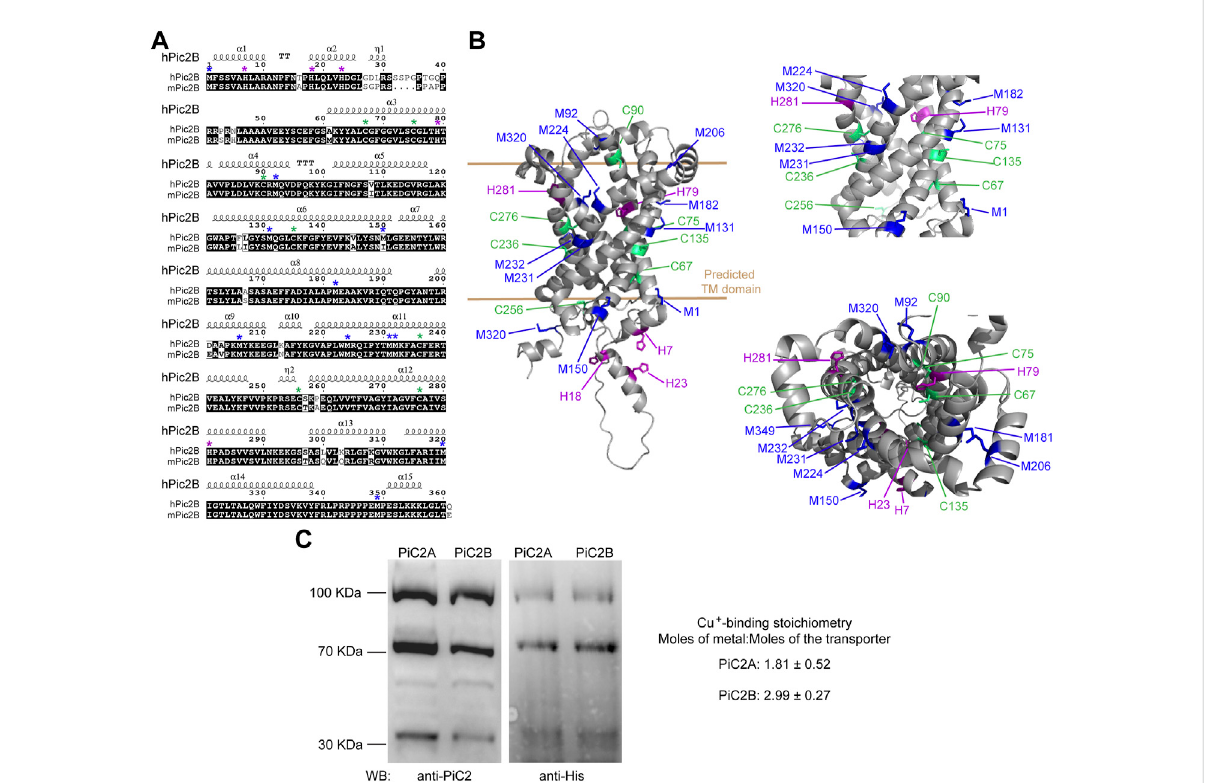
FIGURE 3 mPiC2proteinhasseveralpotentialCubindingsites. (A) SequencehomologycomparisonofthehumanhPiC2BandmurinemPiC2B.Alignment of hPiC2B and mPiC2B amino acid sequences. Areas of homology between the sequences of the two transporters are indicated in black, potential Cu + -binding resides indicated with green asterisks for cysteines, blue asterisks for methionines and purple asterisks for histidines (*). (B) Representative model of mPic2 protein and potential Cu + -binding sites obtained from Alpha fold. Potential Cu + -binding residues indicated in green. (C) Representative western blots of recombinant PiC2A and PiC2B protein expression detected by both anti-PiC2 antibody and anti-His tag antibody. Monomeric, dimeric, and trimeric forms are detected by both antibodies. Cu + -binding stoichiometry of Pic2A and Pic2B. n = 3, results reported as means ±